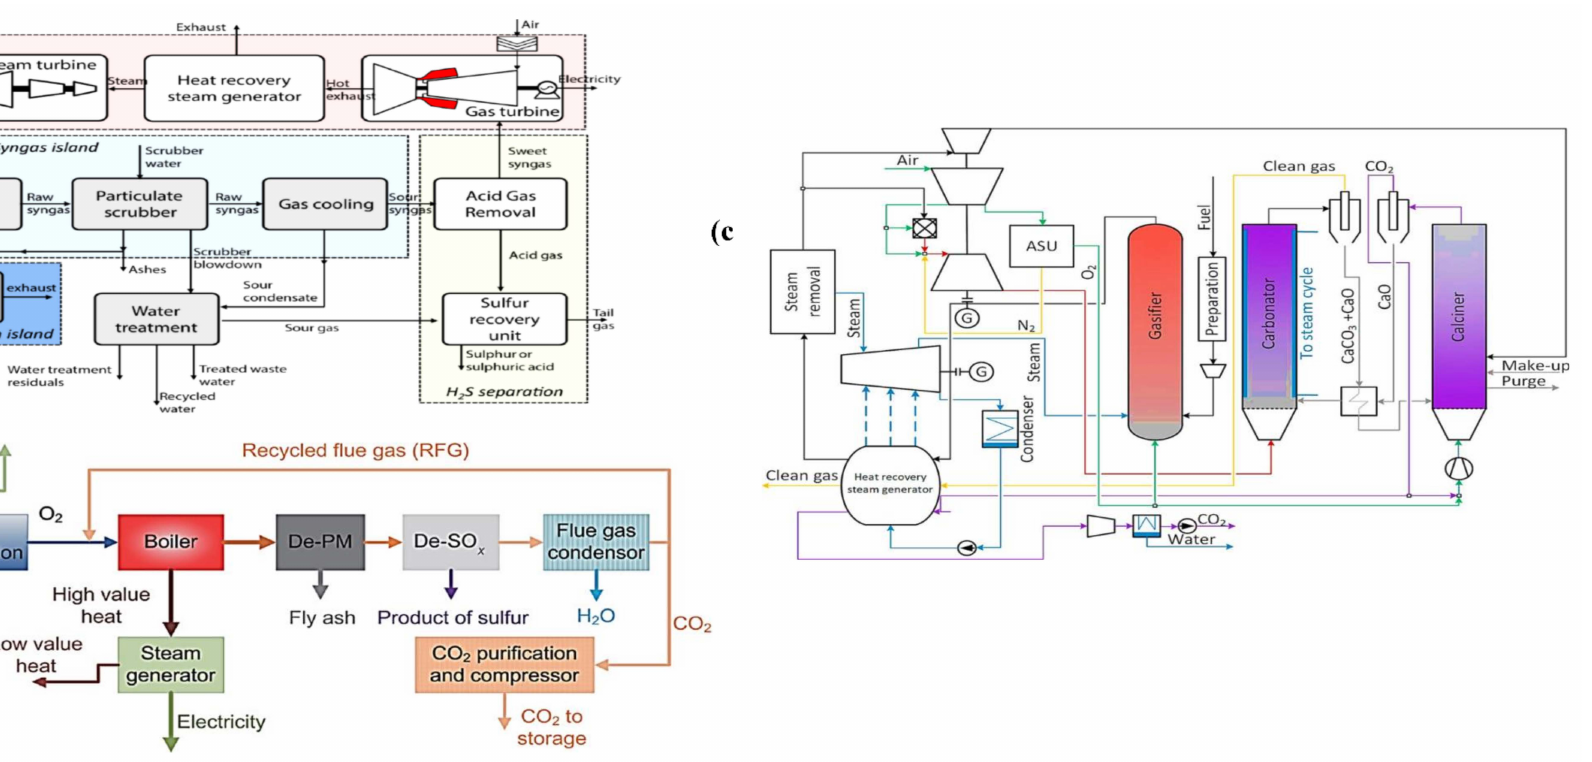
Figure 3. Carbon dioxide capture technology for:( a ) PRC [50], reproduced with permission No. 5402050329104, ( b ) OC [51], open access, ( c ) PC [17], reproduced with permission No.